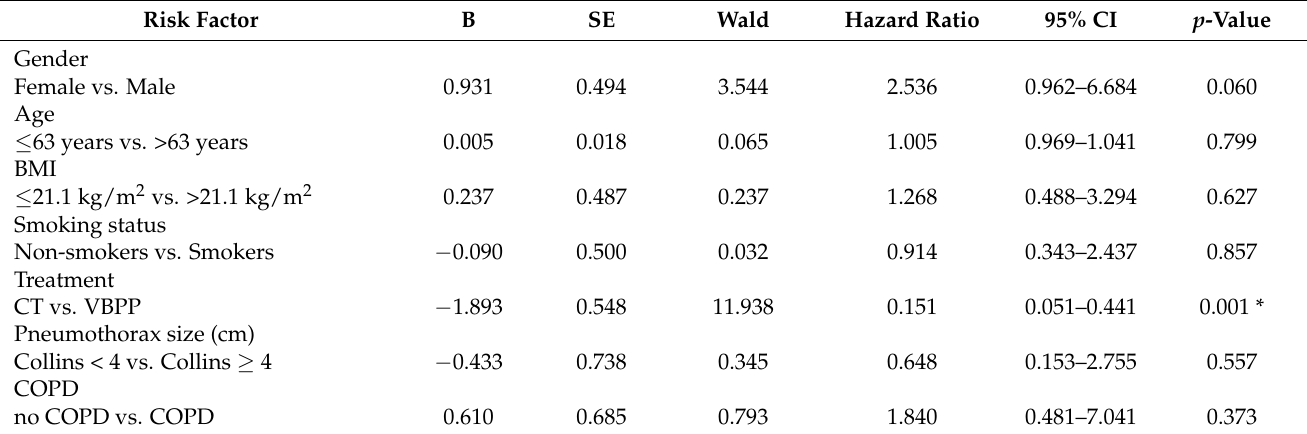
VBPP: VATS-bullectomy with partial pleurectomy, COPD: chronic obstructive pulmonary disease, BMI: body mass index, CI: confidential interval, SSP: secondary spontaneous pneumothorax. Table 4. Multivariate Cox regression analysis of potential risk factors for recurrence of